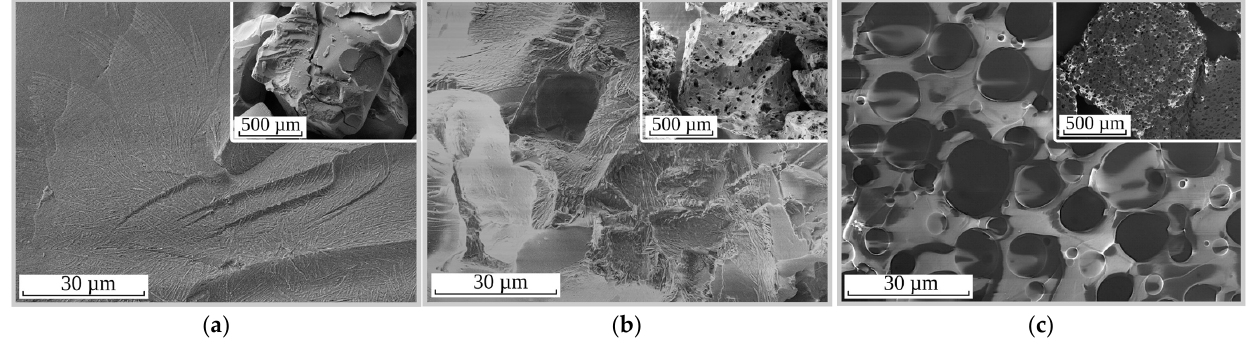
Figure 3. SEM images of the ion exchangers: ( a ) RFR-i, ( b ) RFR-Ca and ( c ) RFR-T.